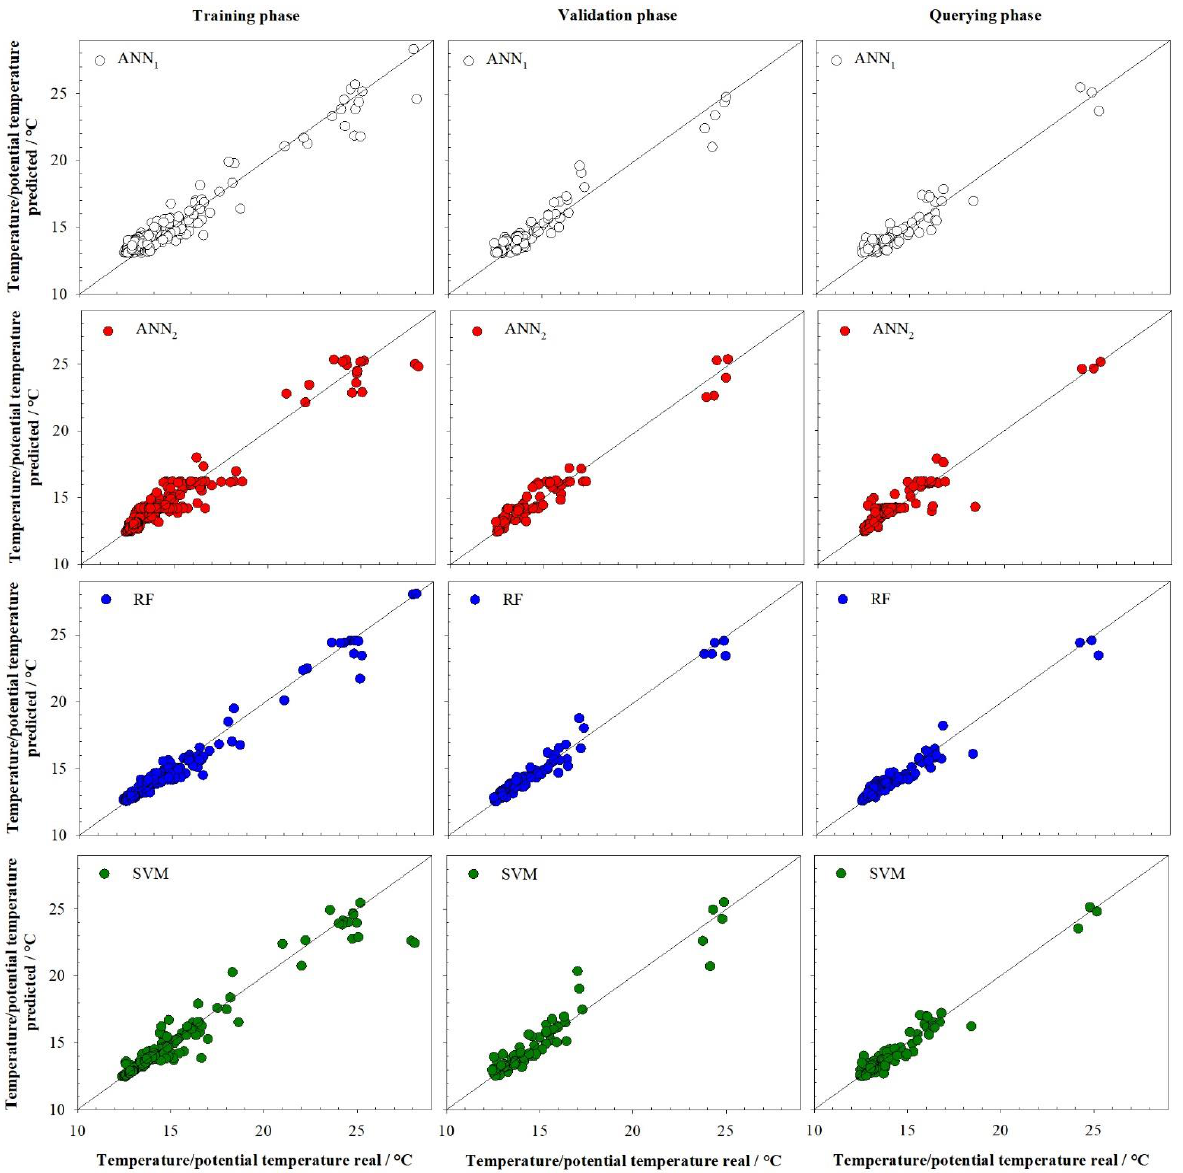
Figure 3. Real values vs. predicted values for temperature/potential temperature (°C) by artificial neural models ANN 1 and ANN 2 , random forest model (RF) and support vector machine model (SVM) developed. The black line corresponds to the line with slope one.